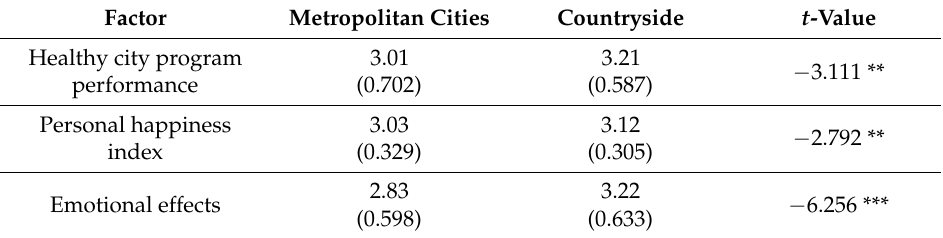
Table 4. Analysis of average differences between metropolitan cities and countryside.